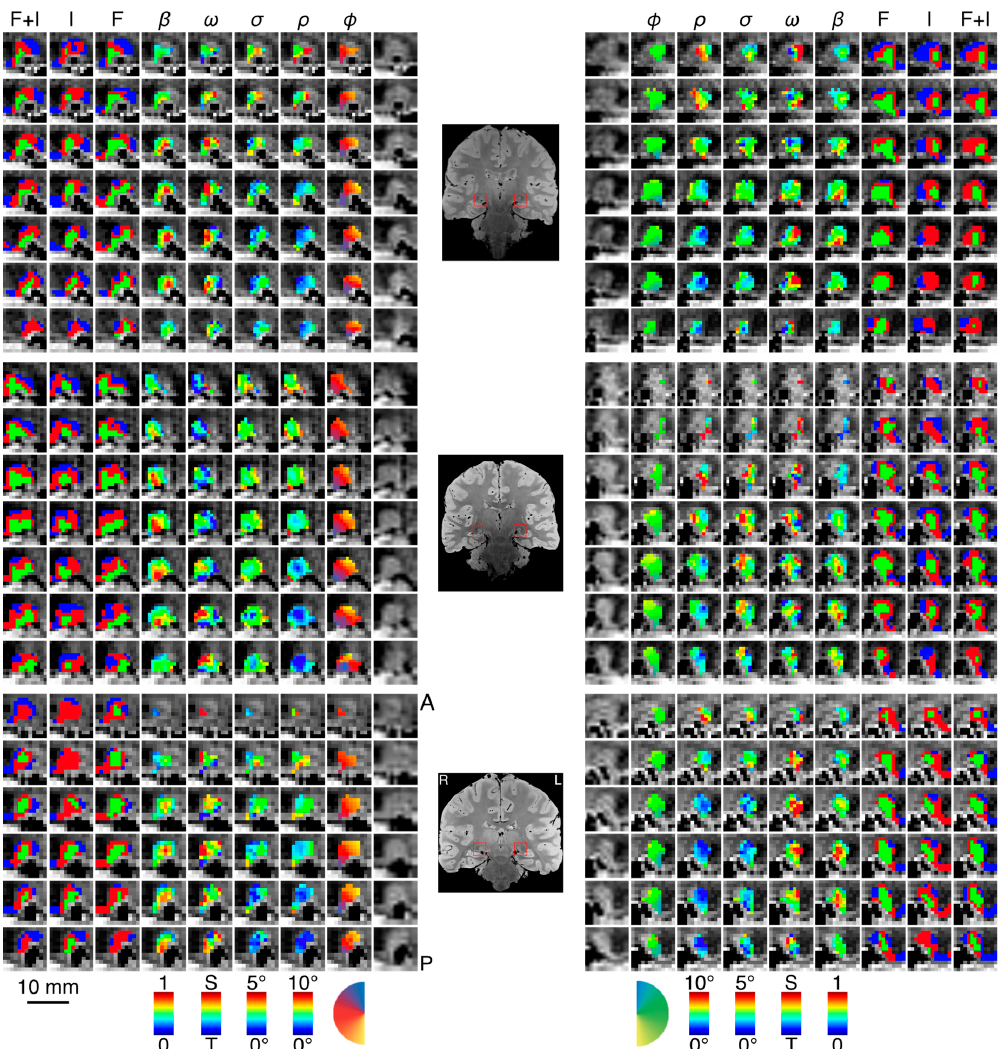
Figure 3. Parameter maps across three subjects. In each panel—top, middle, bottom—we show the left and right LGN for a single subject with the spatiotemporal pRF model estimates overlaid atop the proton-density image. We show a series of contiguous coronal slices moving from anterior to posterior along the rows from top to bottom. The innermost column shows the unlabeled anatomy, followed by the polar angle, the eccentricity, the receptive field size, the transient-sustained mixture, and amplitude. The three outermost columns show the cluster labels derived from data while subjects viewed the full-field flicker stimulus, the full-field isoluminant stimulus, and the full-field flicker and isoluminant concatenated in time. Color maps for each of the parameters are presented at the bottom of the figure below each column. A single coronal slice from each subject’s proton-density image is shown between the left and right hemisphere panels. The left and right LGN are highlighted with a red box. Labels at the top of the figure indicate the parameter ( φ , polar angle; ρ , eccentricity; σ , receptive field size; ω , transient-sustained weight; β , amplitude; F, flicker cluster labels; I , isoluminance cluster labels; F + I , concatenated flicker and isoluminance cluster labels).